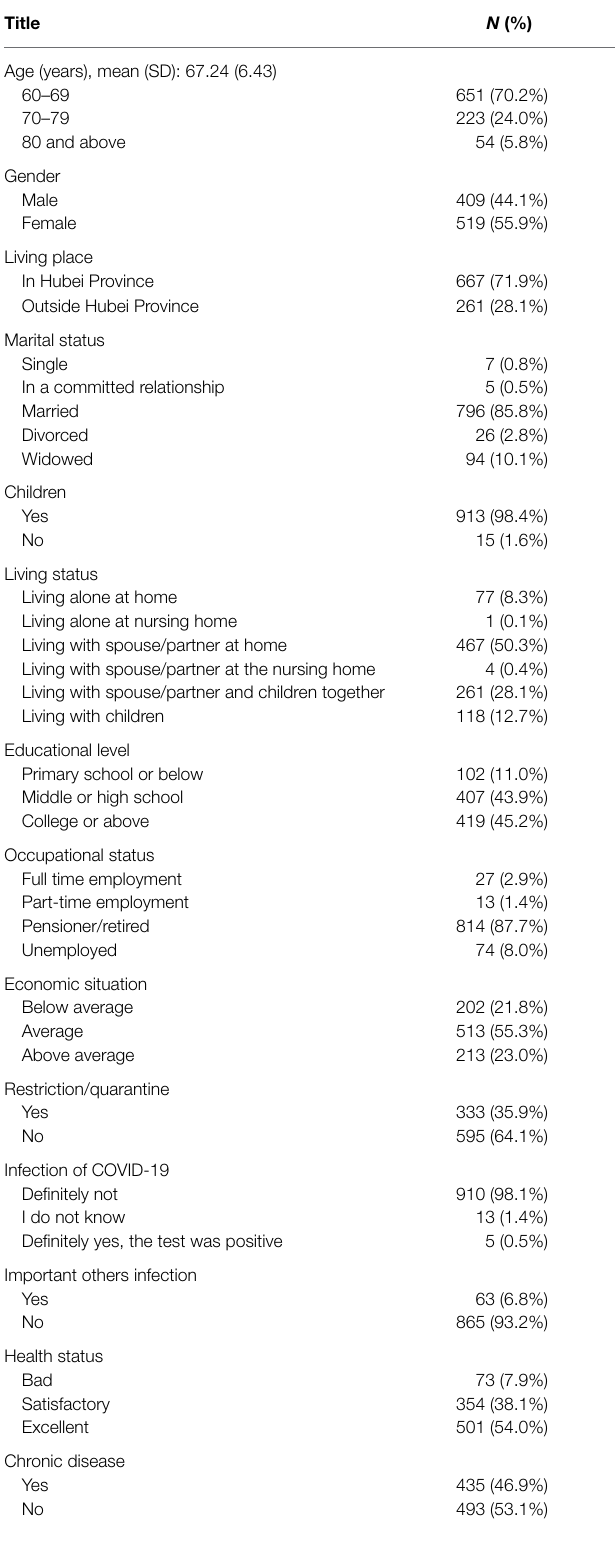
TABLE 2 | Descriptive characteristics of the study sample ( n =